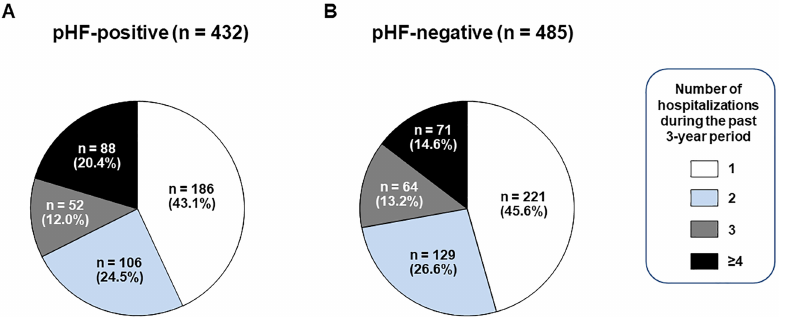
Fig 1. Distribution of the number of all-cause hospitalizations. The possible heart failure (pHF)-positive patients (A) had higher rate of the ‘Repeated-Hospitalization’ ( (cid:21) 4 times during the 3-year period) than the pHF-negative patients (B) (20.4 vs. 14.6%, p =